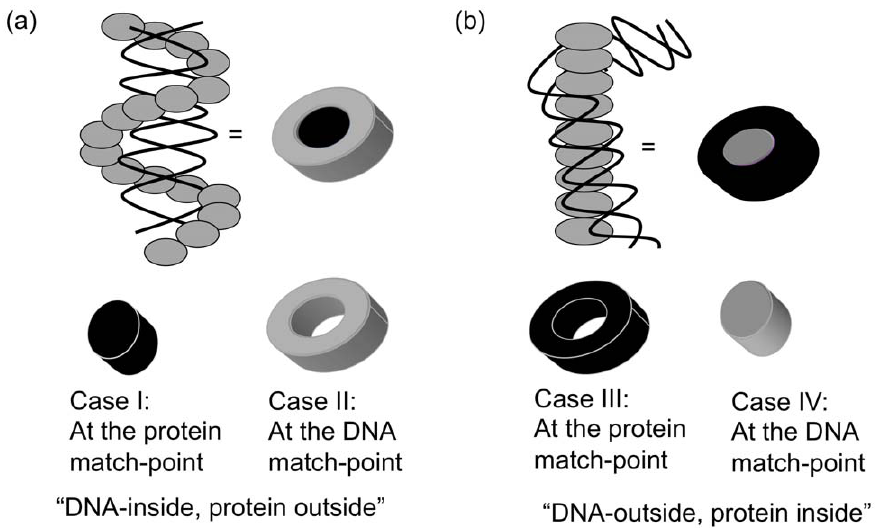
Figure 2. Hypothetical three-dimensional organizations of the partition assembly. Two topologically alternative scenarios can be proposed: (a) a ‘‘DNA inside, protein outside’’ model or (b) a ‘‘DNA outside, protein inside’’ model. The DNA is shown as black line, proteins are shown as grey beads. These models can be described as composite cylinders for low-resolution solution scattering experiments. Anticipated shapes at the protein and the DNA match-point for both models (as narrower or hollow cylinders) are shown as cartoons (case I–IV). The handedness and scale are arbitrary. We note that solution scattering cannot distinguish between the left- and the right-handed senses.